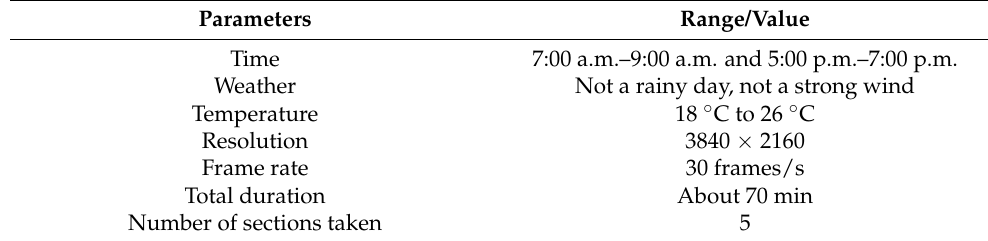
Figure 7. Diagram of the location of the drone shot. Table 1. Traffic video capturing